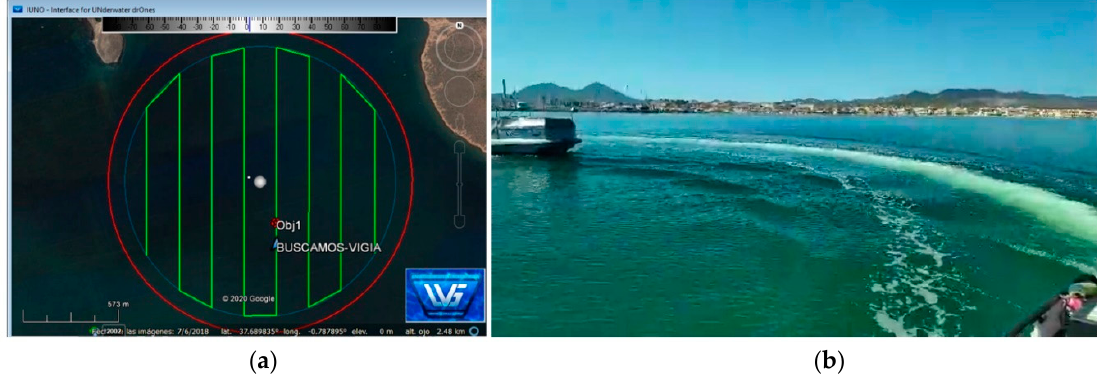
Figure 17. ( a ) Stopped vessel detected. Start TM mode. ( b ) Tracking Mode ( TM ) test during the experiment.